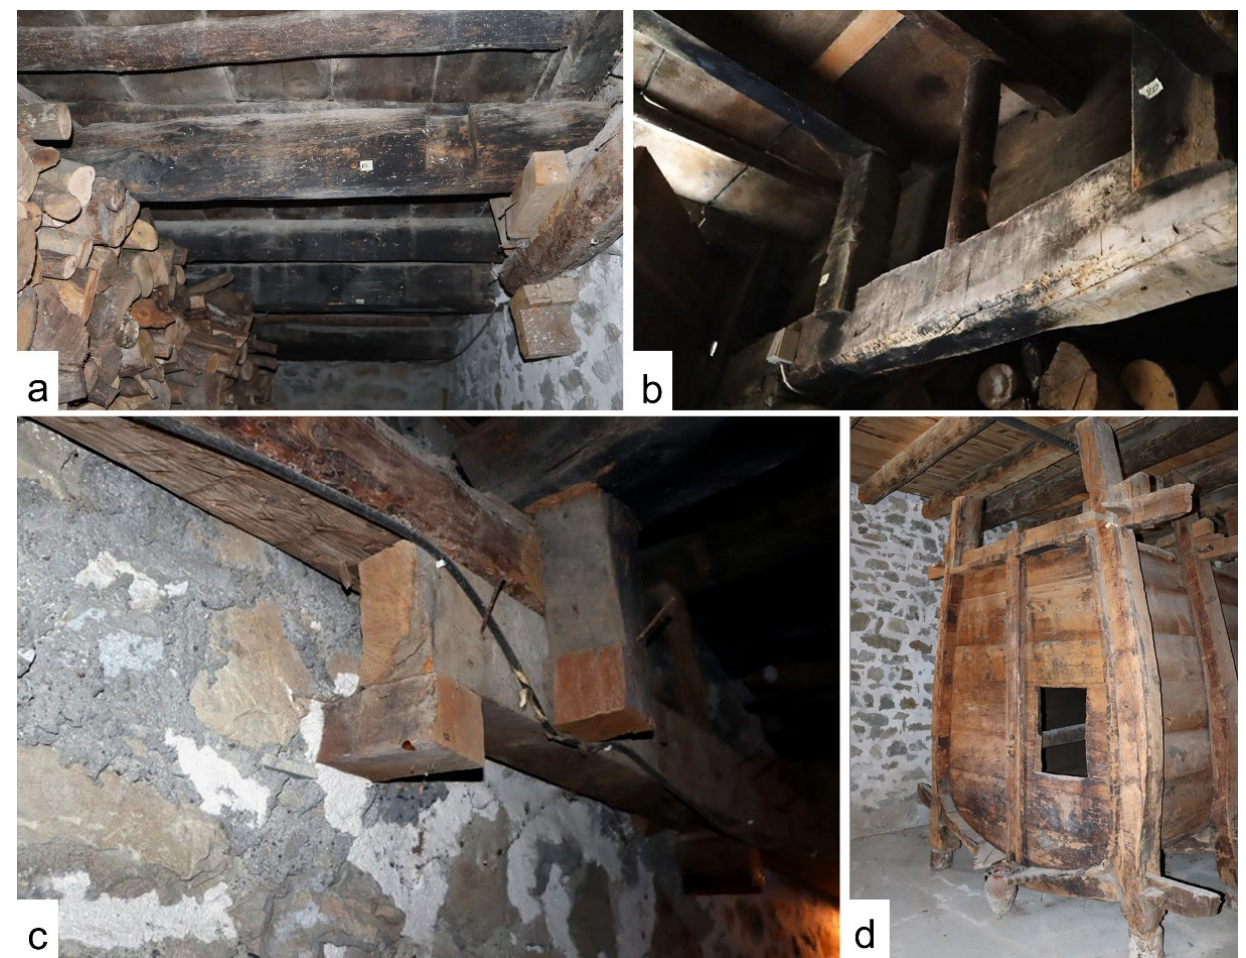
Figure 3. ( a ) Floor beams next to firewood, at the corridor driving to the basement in the auxiliary building; ( b ) vertical elements supporting the floor beams on the horizontal beam placed at the lower level; ( c ) cantilever beams at the lower level, supporting the floor beams with extra timbers ( d ) old wine barrel stored at the basement of the auxiliary building.